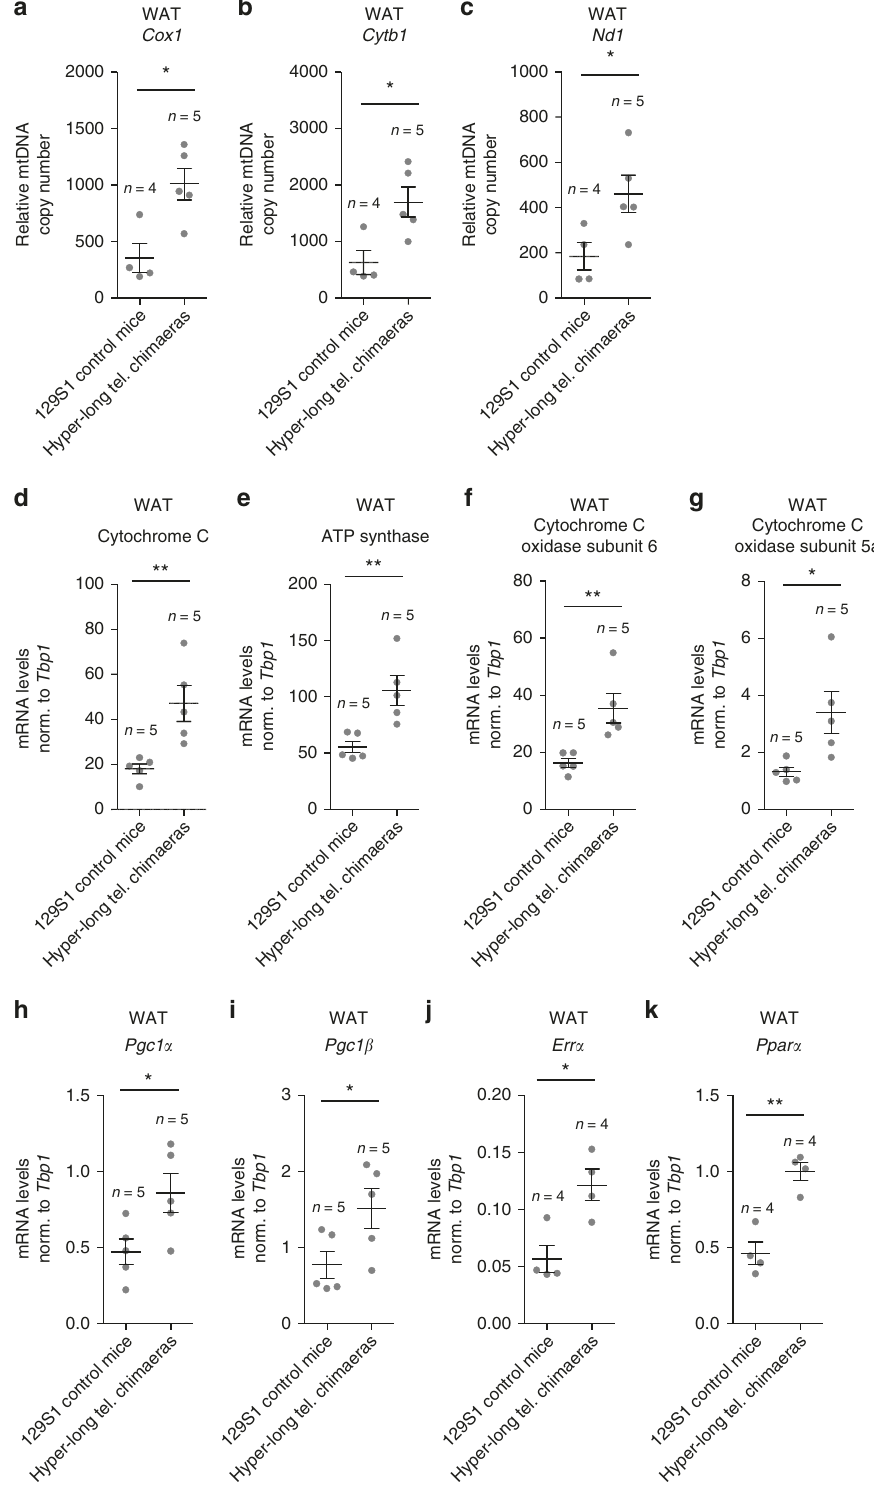
Fig. 9 Improved mitochondrial function in mice with hyper-long telomeres. a – c . Relative mtDNA content was calculated by the comparative Ct method of the mitochondrial genes Cox1 ( a ), Cytb1 ( b ) and Nd1 ( c ) compared to the nuclear gene H19 in WAT of 100 – 110 weeks old hyper-long telomere mice and age-matched controls. d – k . mRNA levels from WAT of the OXPHOS genes Cytochrome C ( d ), ATP synthase ( e ), Cytochrome C subunit 6 ( f ) and Cytochrome C subunit 5a ( g ) as well as mitochondrial regulators PGC-1a ( h ) and PGC-1b ( i ) and critical targets, such as ERRa ( j ) and PPARa ( k ). Error bars represent standard error. t -test was used for statistical analysis. The number of mice is indicated in each case. * p < 0.05. ** p < 0.01. Source data are provided as a Source Data fi